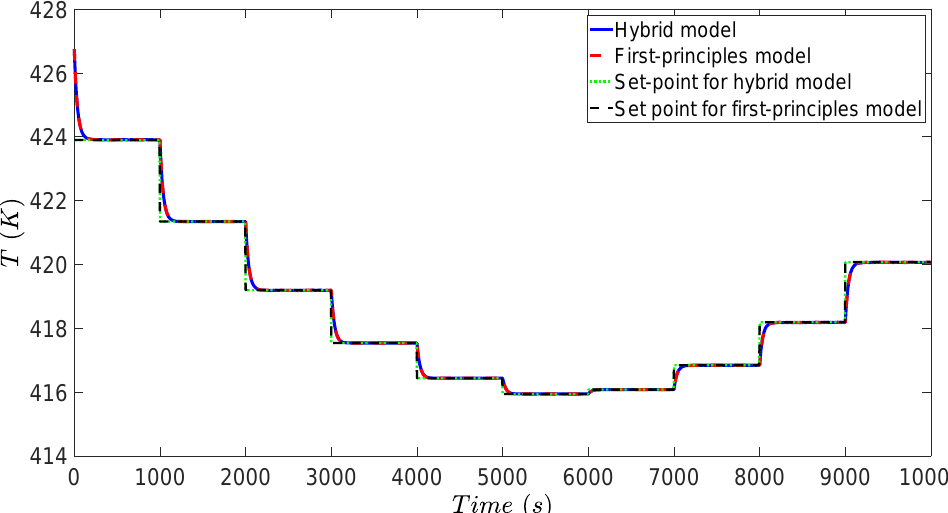
Figure 6. Evolution of the reactor temperature T for the CSTR case study under the proposed RTO and MPC scheme.